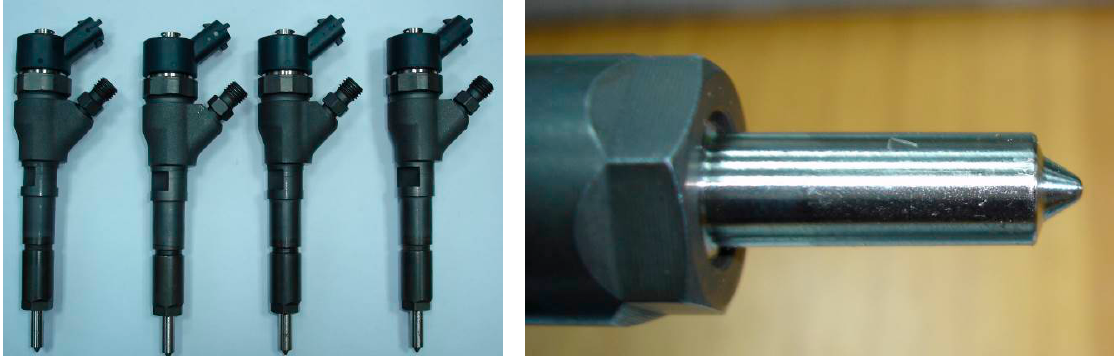
Figure 9. New set of common-rail injectors ( left ) and injector nozzle ( right ).